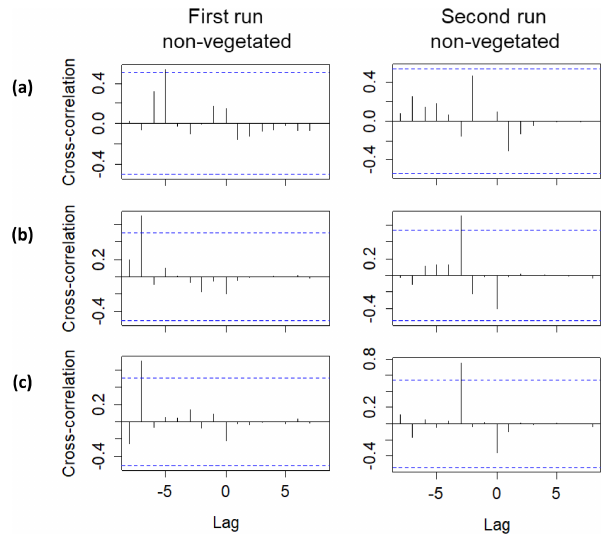
Figure 5. Lag analysis performed using the Br − breakthrough curves for the first and second runs between the following sam- pling depths: (a) 39 and 3cm, (b) 39 and 15cm and (c) 39 and 27cm. Only significant lag correlations are displayed. Lag units are given in days (corresponding to the dates when the observations were made). The blue lines represent the approximate 95% confi- dence intervals. Table 3. Spearman rank correlation between the breakthrough curves of Br − of the first and second runs and the different depths and